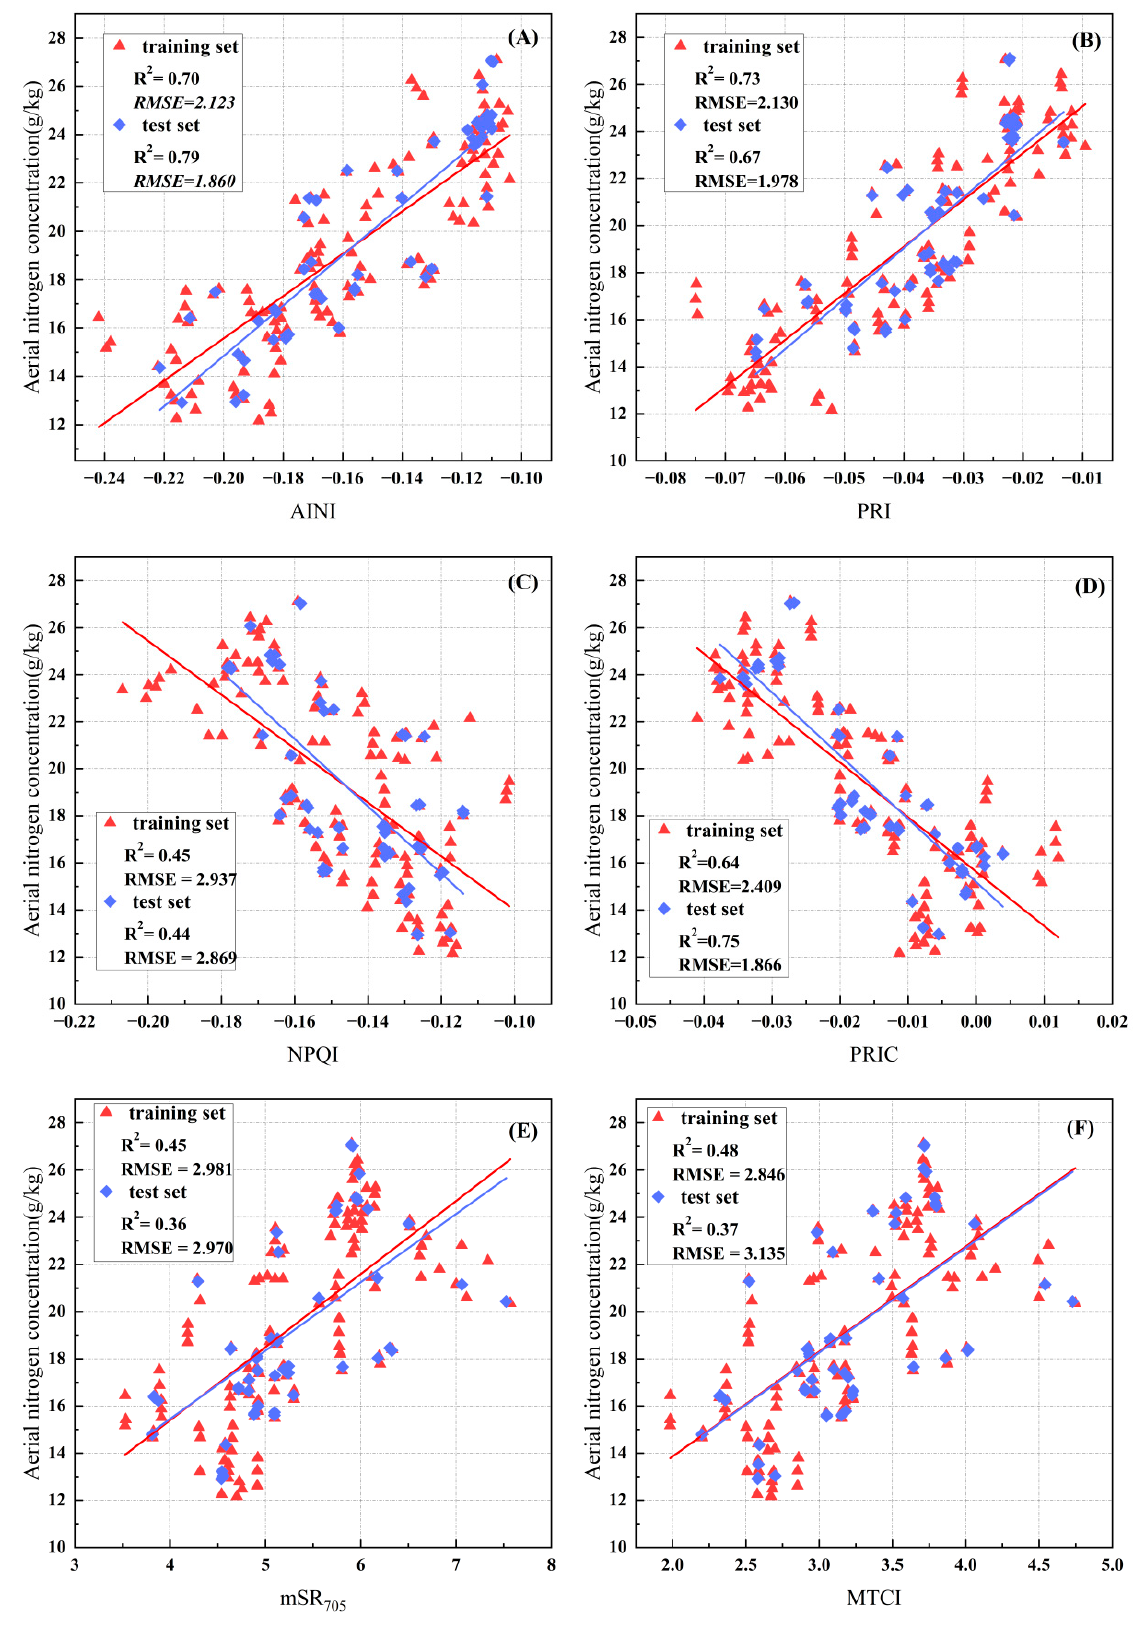
Figure 8. Linear relationship between 0 ◦ ANC and spectral index: ( A ) 0 ◦ PRI, ( B ) 0 ◦ AINI, ( C ) 0 ◦ NPQI, ( D ) 0 ◦ PRIC, ( E ) 0 ◦ mSR705, ( F ) 0 ◦